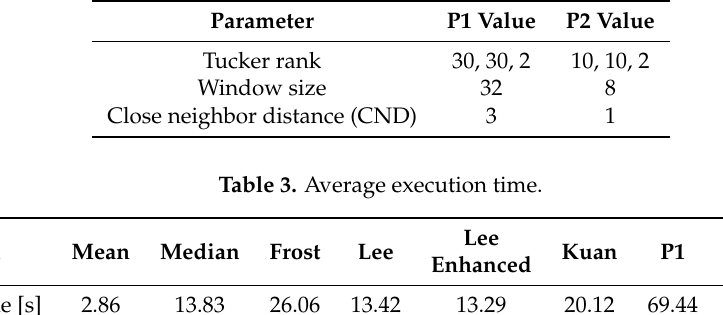
Table 2. Input parameters for the P1 and P2 methods.